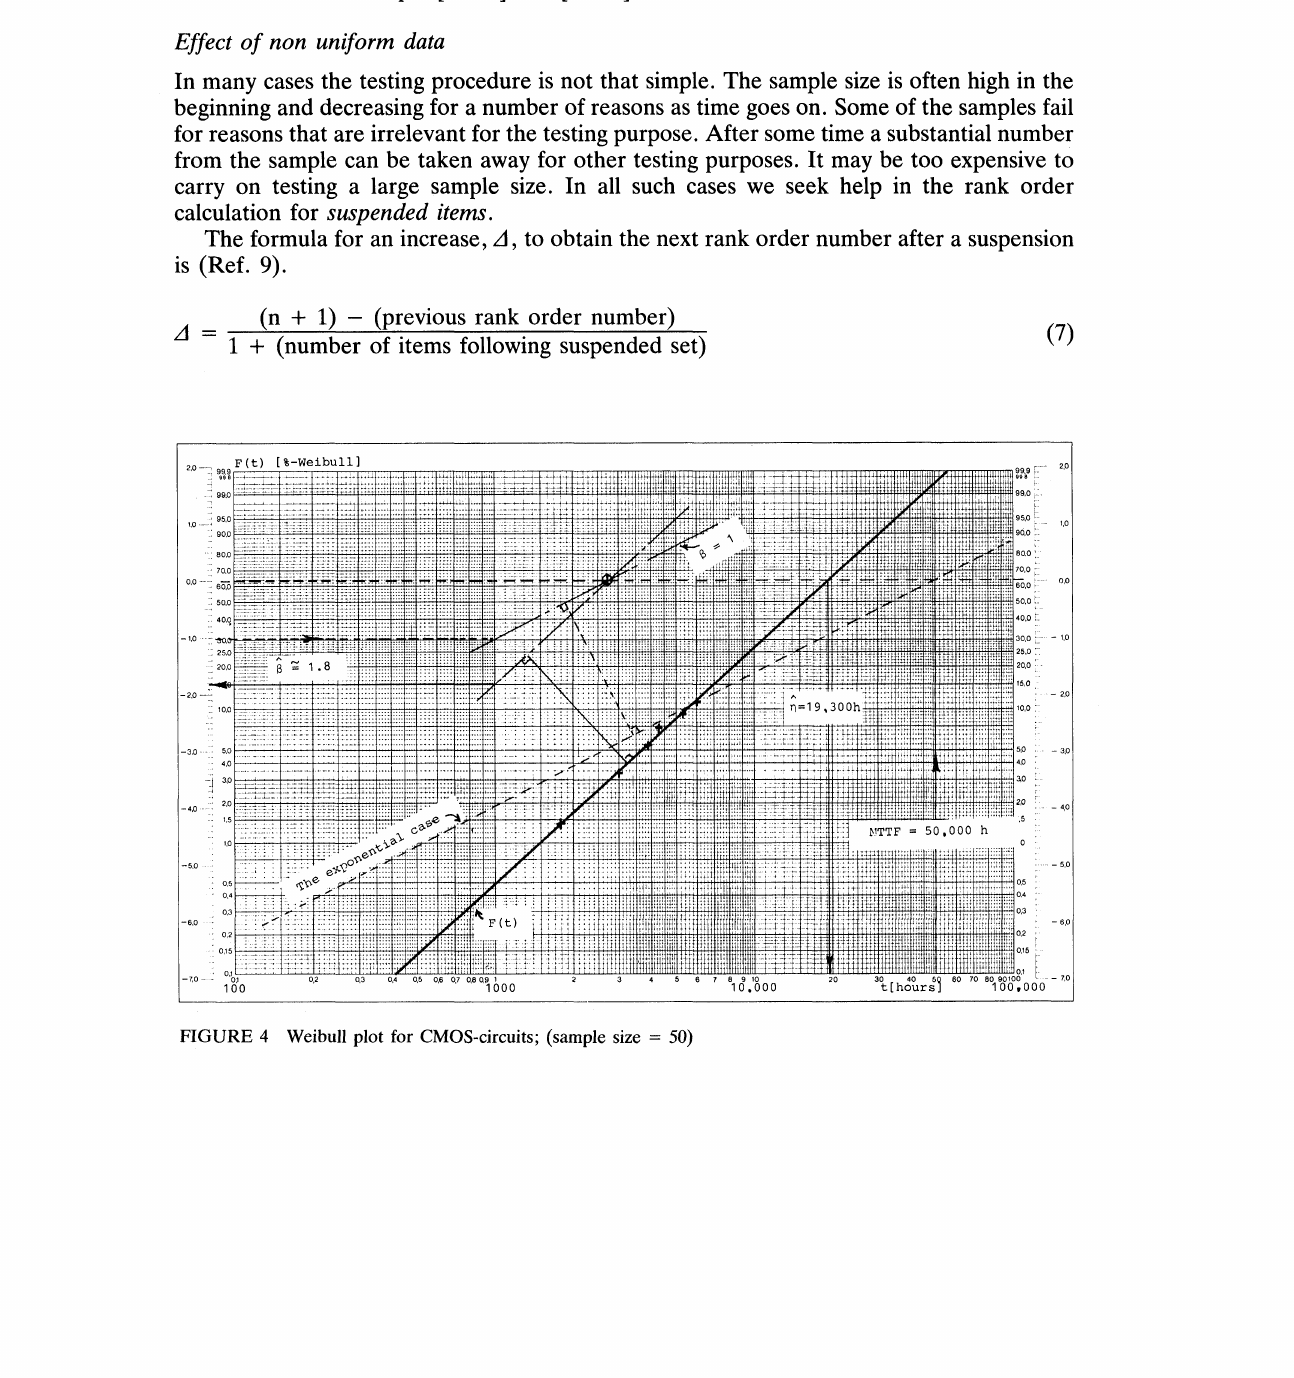
FIGURE 4 Weibull plot for CMOS-circuits; (sample